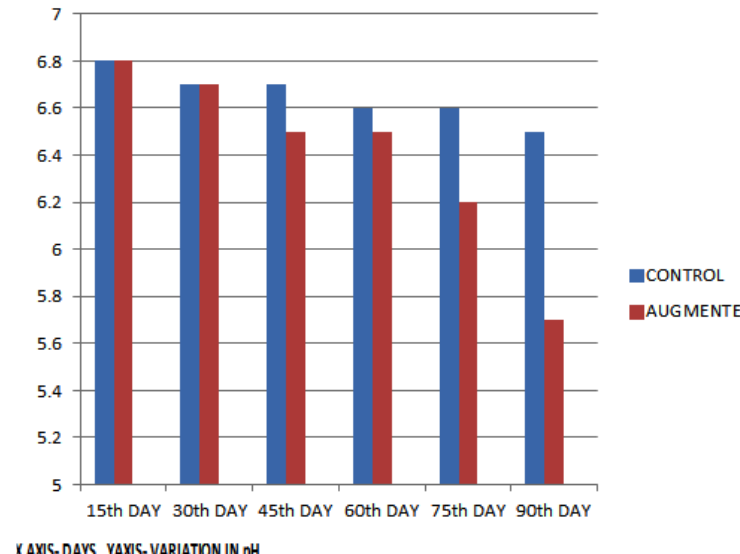
Fig. 3. Variation in pH - Control and Augmented